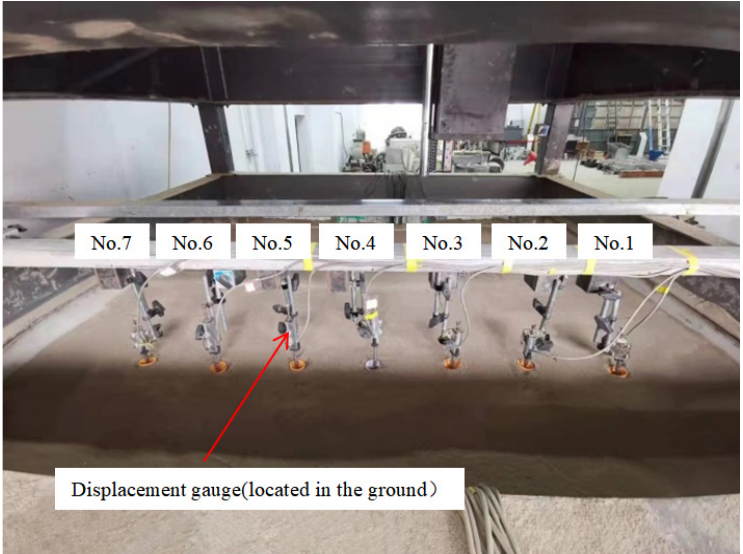
Figure 4. Arrangement of displacement gauges for measuring ground settlement on the sand surface. ( The label of displacement meter is from the 1st to the 7th ).